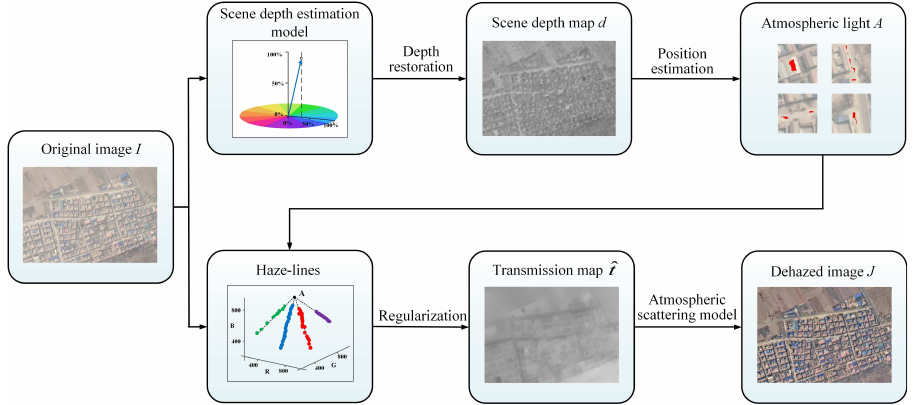
Figure 2. The proposed dehazing framework for remote sensing